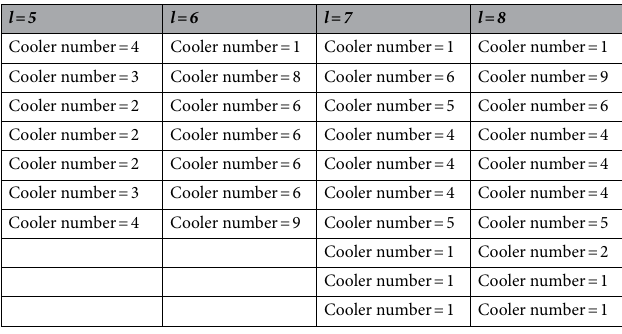
Table 4. Turning on the cooling